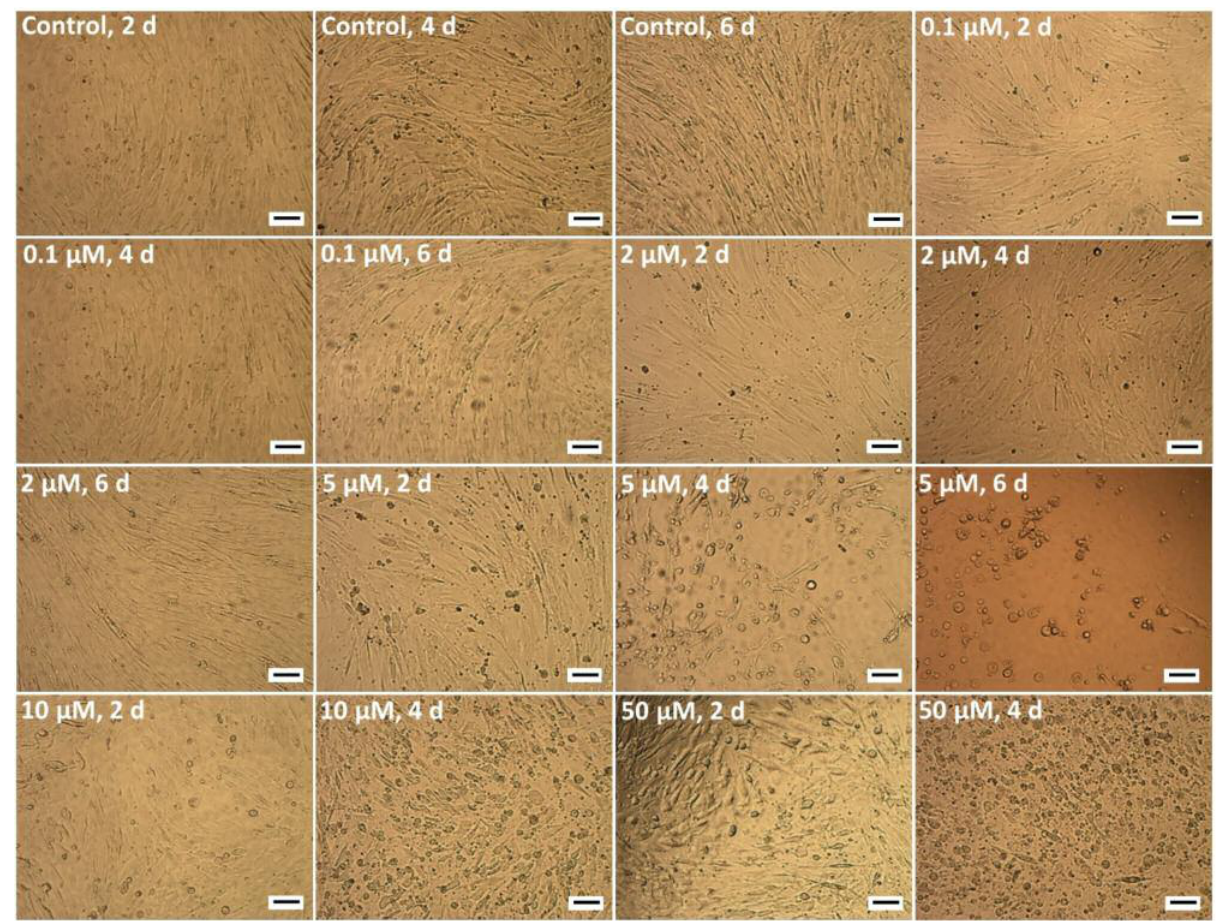
Figure 1. Phase contrast microphotographs of Cd-treated human osteoblasts after 2, 4 and 6 days of cultivation, respectively. Mag- nification × 100; Bar = 0.1 mm.